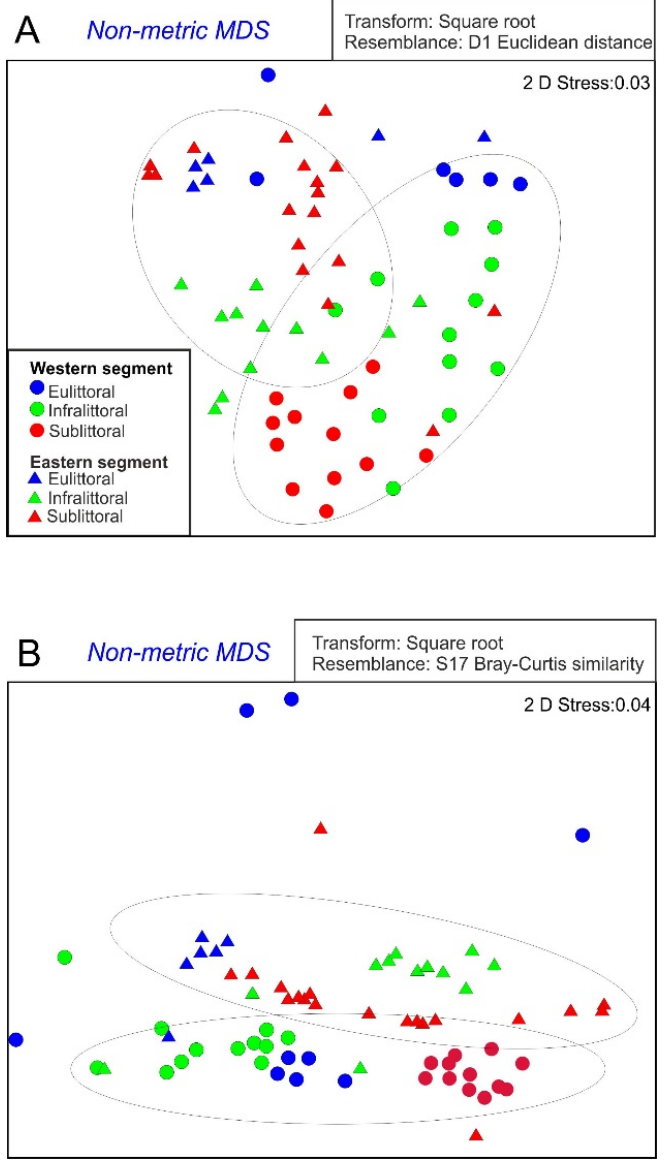
Figure 2. Results of non-metric multidimensional scaling (NMDS) ordinations showing the similarity of sampling sites in two segments of the study lake: ( A ) based on Carlson trophic state index (CTSI); and ( B ) based on the structure of benthic macroinvertebrate communities using invertebrate diversity.